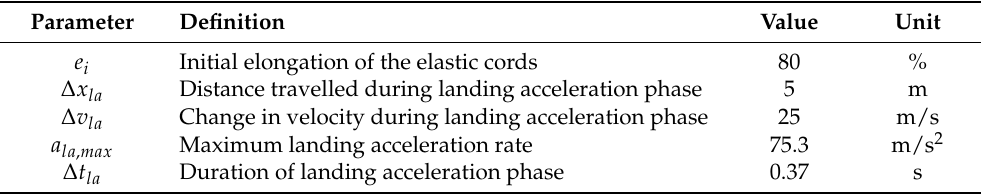
Figure 10. The carriage dynamics due to the landing acceleration phase ( a ) and the landing decelera- tion phase ( b ). Table 8. The dynamics of the carriage during the landing acceleration phase.